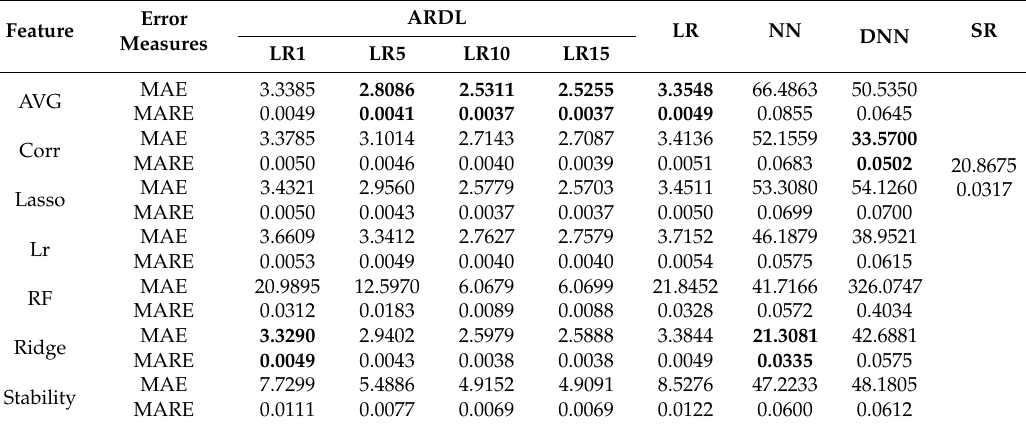
Table 4. Results of models for forecasting the HPTET temperature.